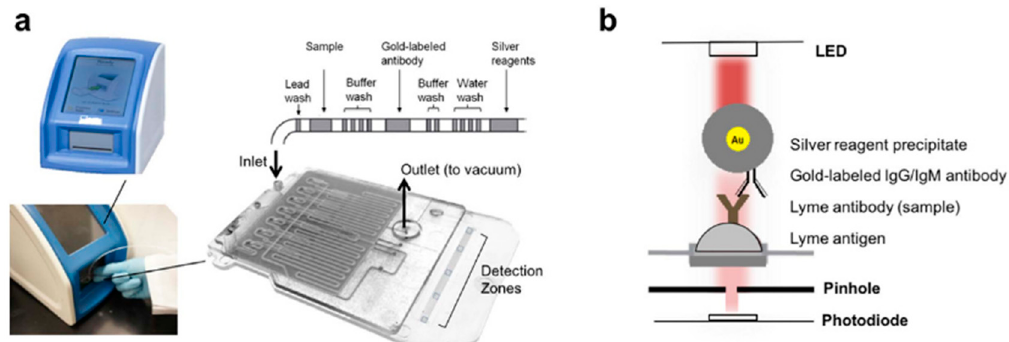
Figure 1. The mChip-Ld system showing ( a ) the microfluidic device and the order of buffers which are added to it, as well as the benchtop analyzer it is inserted into ( b ) the ordered binding of reagents and molecules within the detection zone. Reprinted from ref [32], which is open access under the Creative Commons Attribution 4.0 International license.